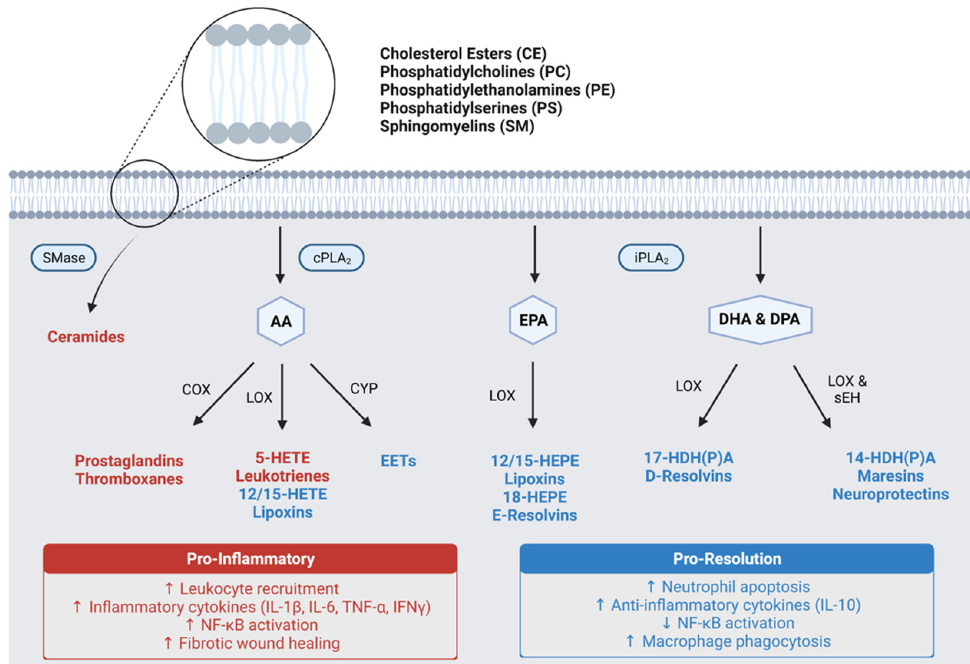
Figure 1. Pro-inflammatory and pro-resolution lipid metabolism pathways. AA, arachidonic acid; EPA, eicosapentaenoic acid; DHA, docosahexaenoic acid; DPA, docosapentaenoic acid; cPLA2, calcium-dependent phospholipase A2; iPLA2, calcium-independent phospholipase A2; SMase, sph- ingomyelinase; COX, cyclooxygenases; LOX, lipoxygenases; CYP, cytochrome P450; EETs, epoxye- icosatrienoic acids; HETE, hydroxyeicosatetraenoic acid; HEPE, hydroxyeicosapentaenoic acid; HDHA, hydroxydocosahexaenoic acid; HDPA, hydroxydocosapentaenoic acid; NF- к B, nuclear fac- tor-kappa B; IL-1 β , interleukin-1 beta; IL-6, interleukin-6; TNF- α , tumor necrosis factor-alpha; IFN γ , interferon gamma; IL-10, interleukin-10.